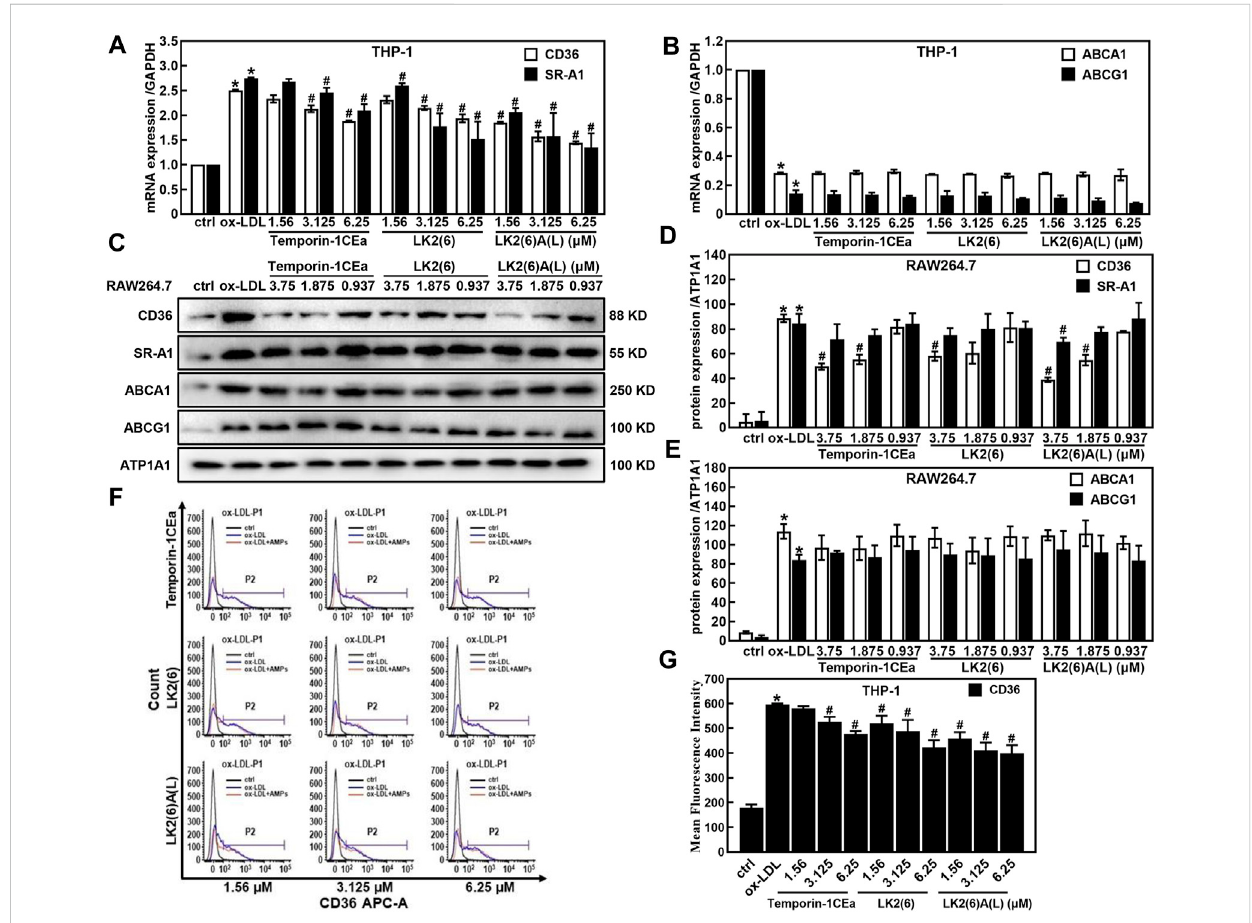
FIGURE 3 Effects of frog skin AMPs on lipid metabolism in ox-LDL induced foam cells. Gene expression of membrane proteins involved in ox-LDL uptake and cholesterol ef fl ux by real-time quantitative PCR in foaming THP-1 cells (A,B) and GAPDH was used as an internal reference; Expression of proteins involved in ox-LDL uptake and cholesterol ef fl ux by Western blot in foaming RAW264.7 cells (C – E) and ATP1A1 was used as an internal reference; Flow cytometry analysis of CD36 expression in foaming THP-1 cells (F,G) . * p < 0.05 vs. the ctrl group. # p < 0.05 vs. the ox-LDL